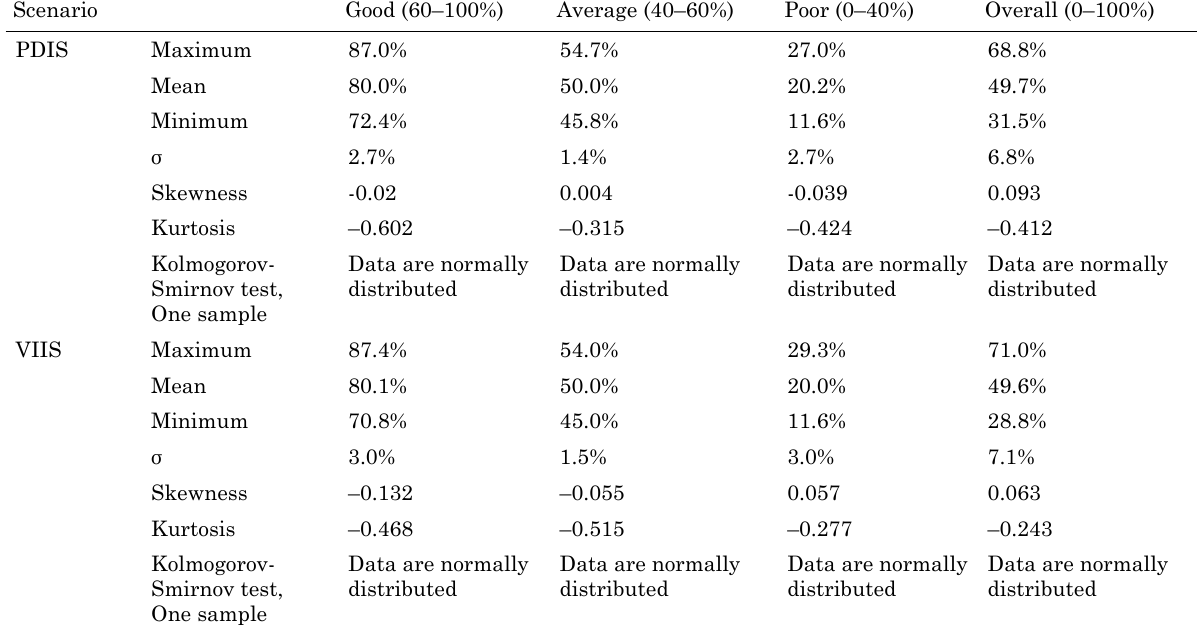
Table 4. Summary of simulated PDIS and VIIS after 1,000 iterations for each scenario